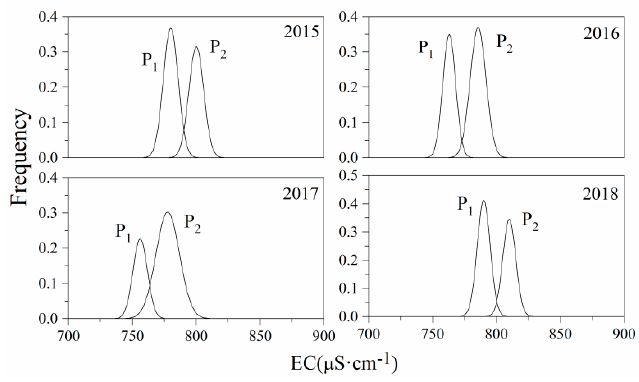
Figure 5. The conductivity frequency distributions (CFDs) of the Baotu Spring.